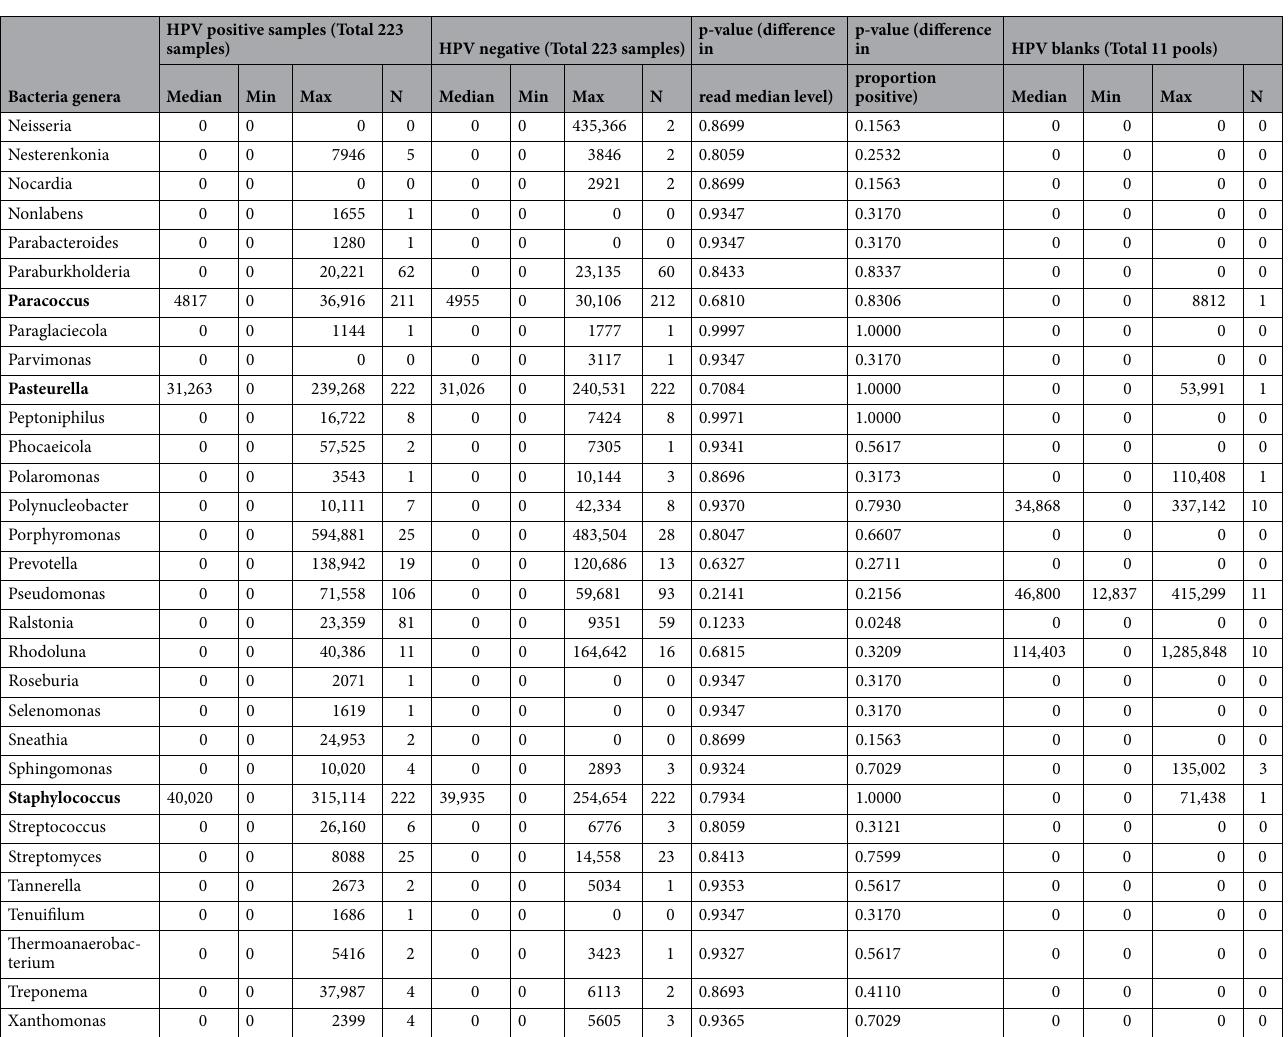
Table 1. Bacterial genera and annotated reads detected in cervical cancer specimens. Bacterial genera highlighted in bold correspond to genera presenting a positive median number of annotated reads/sample. Genera are reported when comprising at least 10 reads and being at least 1% of total bacterial